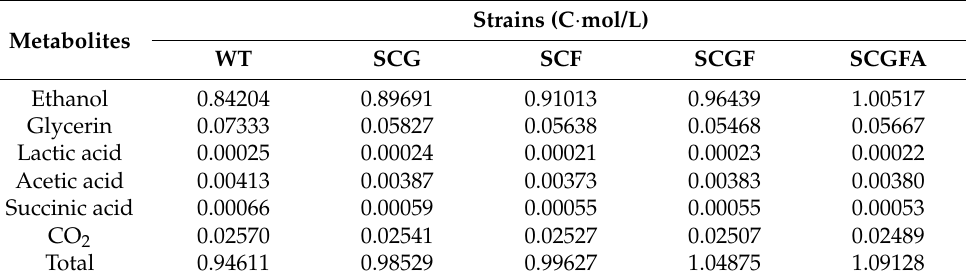
Table 2. Contents of metabolites of different S. cerevisiae strains.